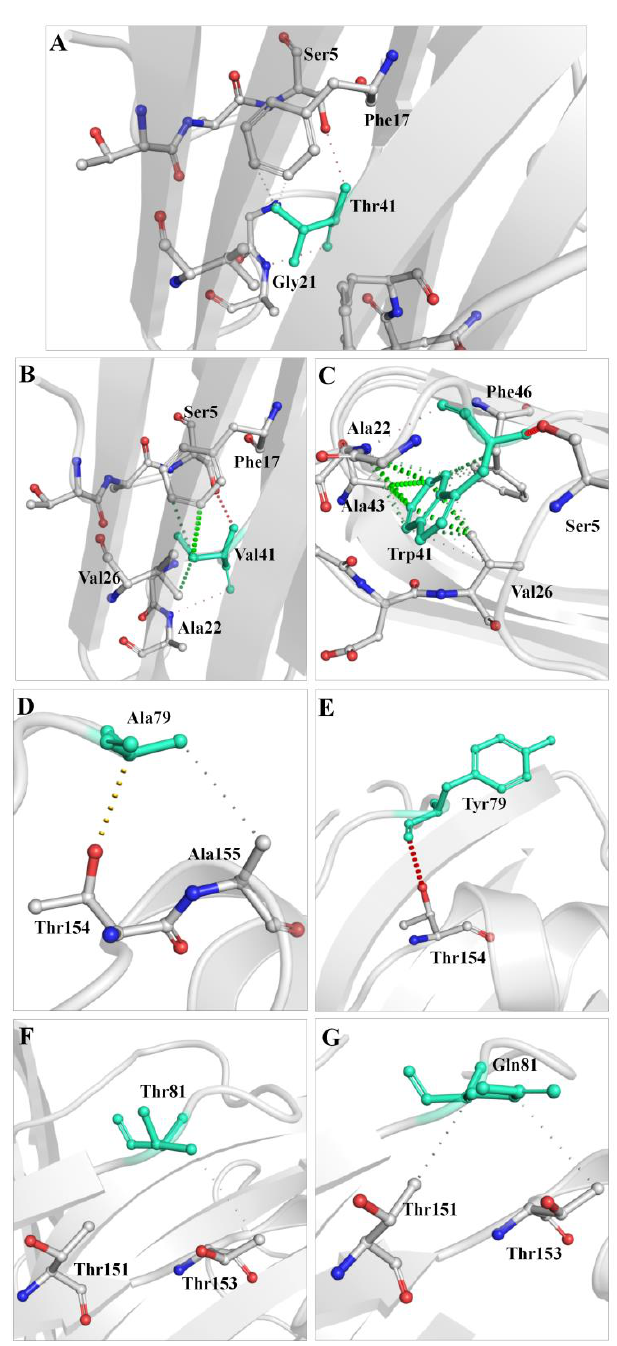
Figure 4. Intramolecular interactions of wild-type ( A,D,F ) and single mutants ( B,C,E,G ) residues predicted by DynaMut web server. The cyan stick modes show mutated residues. The color of each interaction type is defined as follows: green represents hydrophobic contacts; orange represents weak hydrogen bonds; red represents hydrogen bonds; yellow represents ionic interactions.